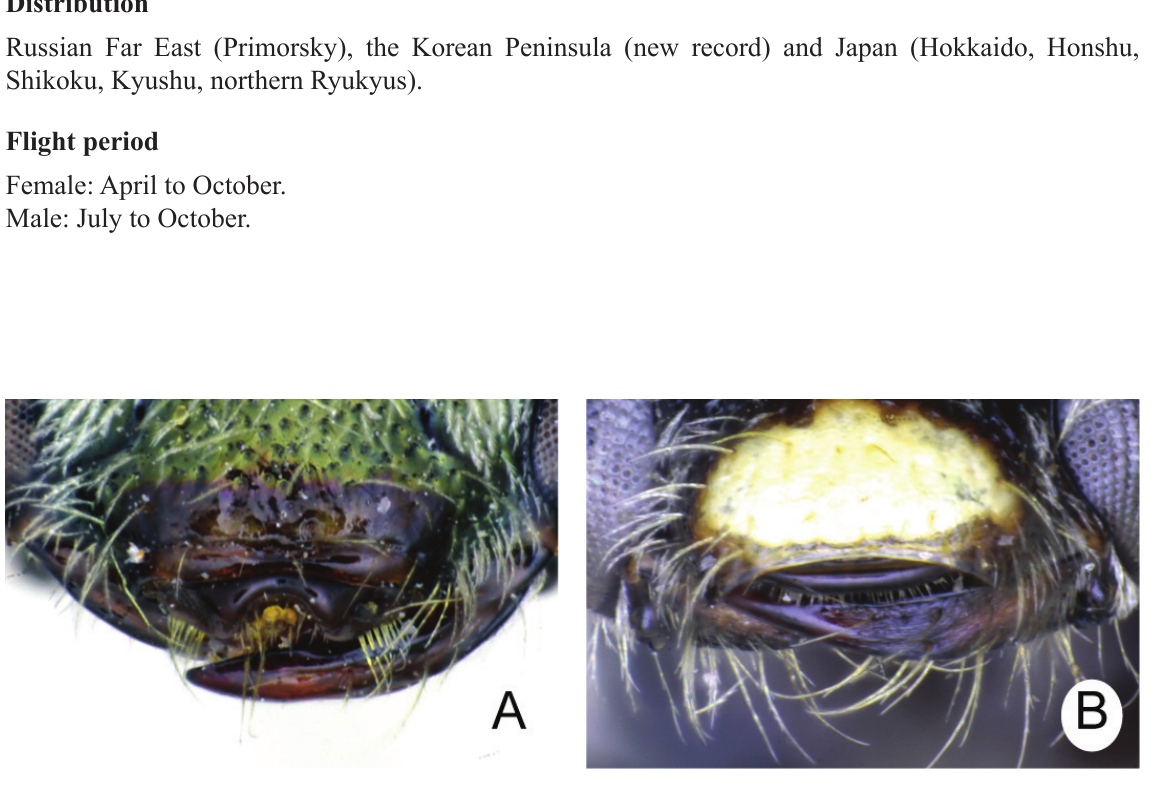
Fig. 27. Photographs for keys: labrum of male. A . Lasioglossum ( Dialictus ) viridellum (cockerell, 1931). B . L . ( D .) problematicum (Blüthgen, 1923).